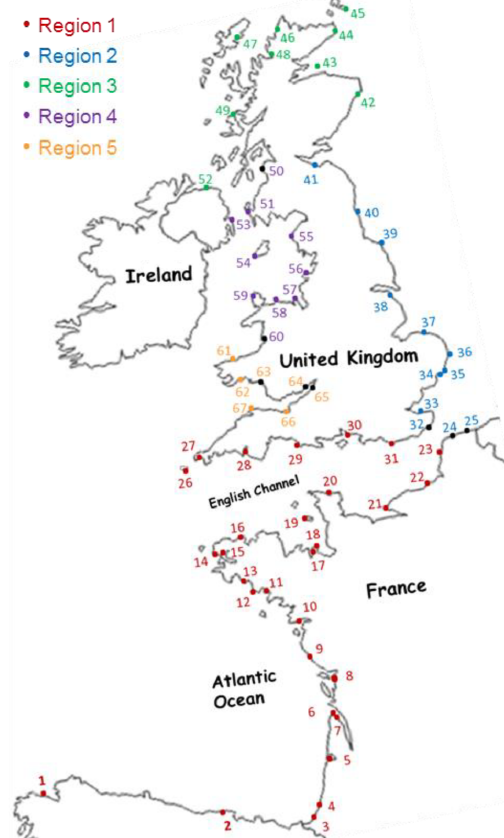
Figure 3. Five physically and statistically homogenous regions (ac- cording to Weiss, 2014). The regions are represented by five col- ors. This figure shows that, for example, site 24 (Calais) is located in the region shown in blue and is very close to a border. Site 23 (Boulogne), however, which is very close to site 24 (Calais), is nev- ertheless in another region (the region shown in red). This separa- tion between site 23 and site 24 may seem